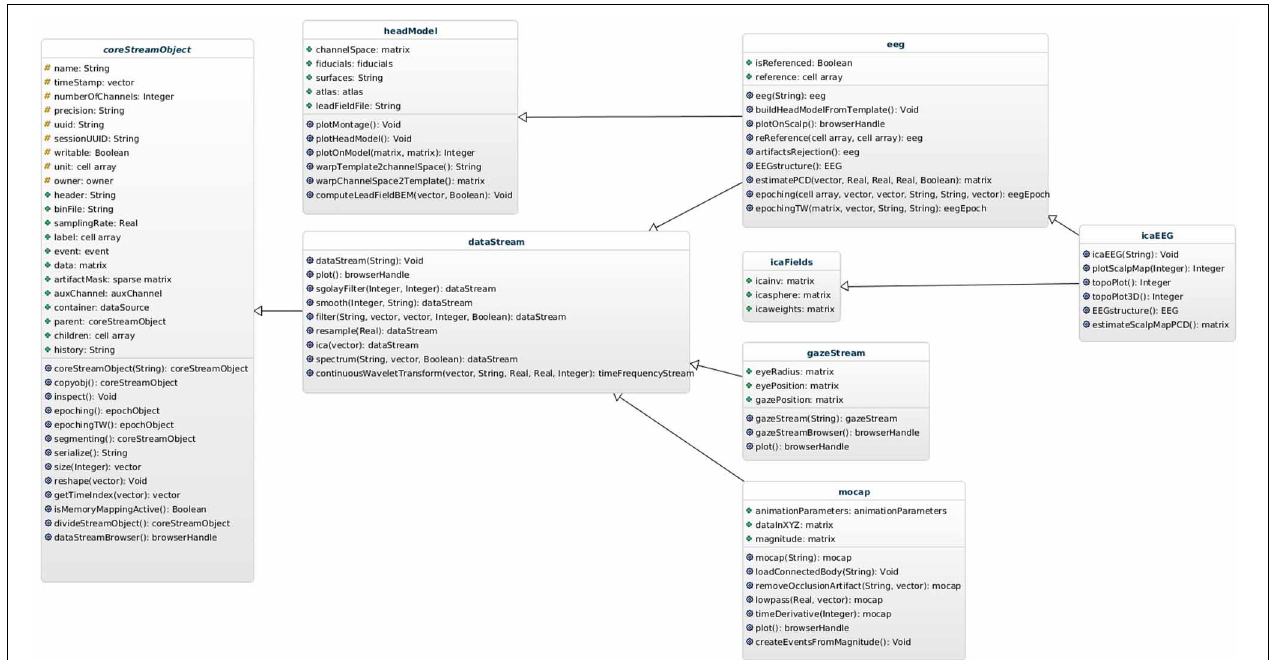
FIGURE 2 | The dataStream class hierarchy. From lefttoright: the baseclass coreStreamObject . This is the common ancestor of all data stream objects, it defines the underlying machinery for storing data in a memory-mapped source file and accessing it as a matrix though its data property. Next (right) in the hierarchy is the dataStream class that defines methods for processing generic